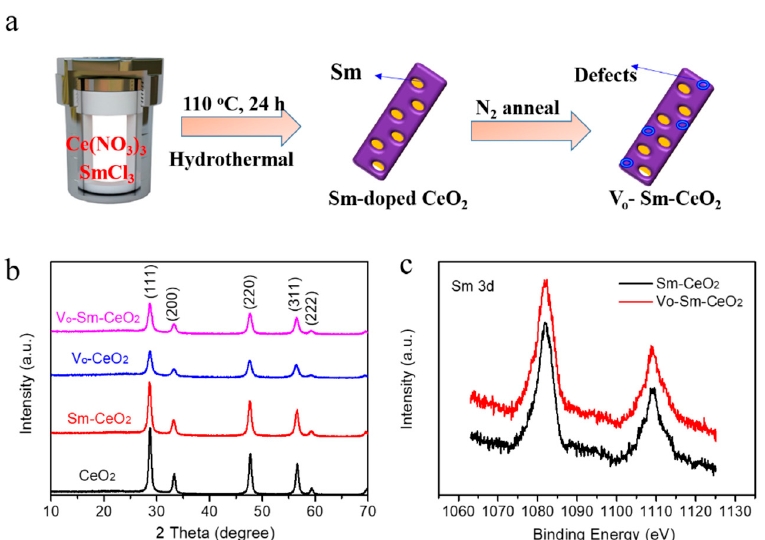
Figure 1. ( a ) Sketch map for preparing Vo–Sm–CeO 2 sample. ( b ) XRD spectra of CeO 2 , Sm–CeO 2 ,